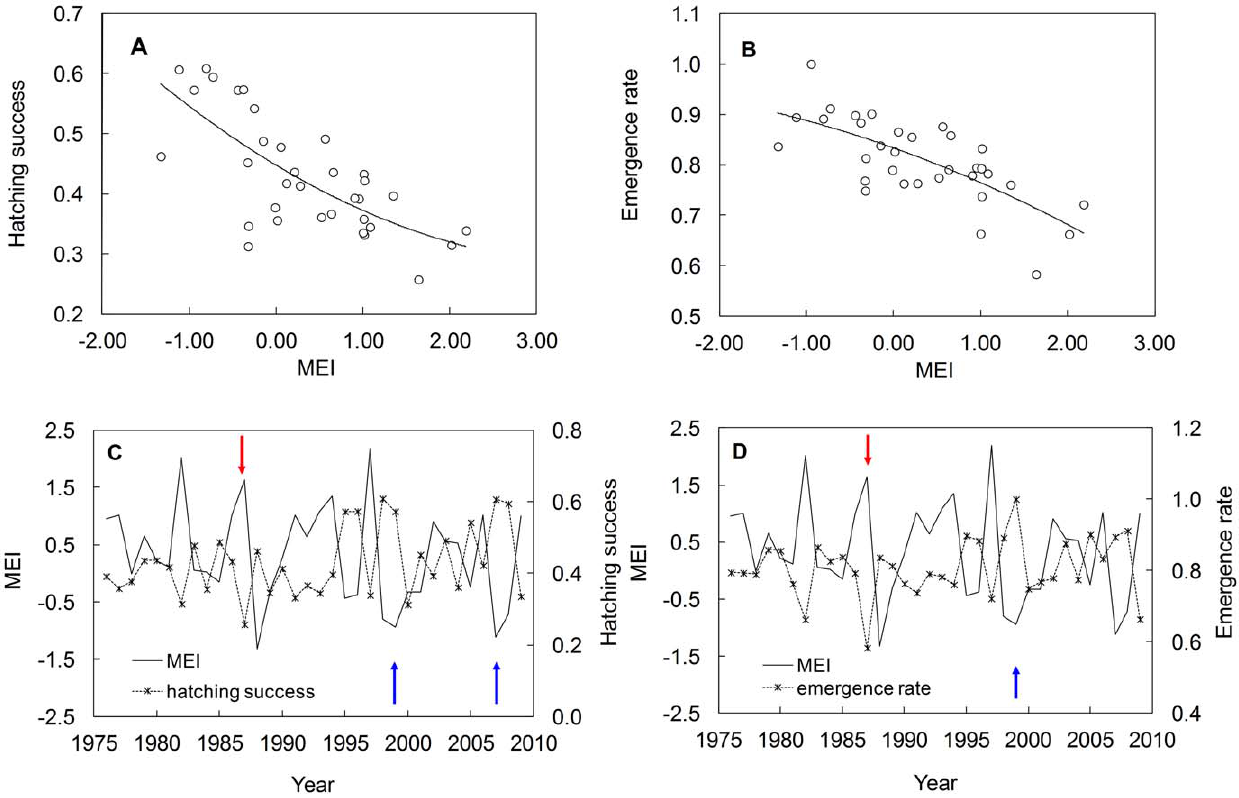
Figure 3. Hatching success and emergence rate hindcasts from 1976–1977 to 2009–2010 related to MEI. (a,b) hindcast of hatching success and emergence rate in relation to MEI of September-October ( R 2 =0.52, P , 0.001 for both); (c,d) hindcast of hatching success and emergence rate (dashed lines with x’s) related to MEI (solid lines) of September-October by year. Lowest and highest hindcasts are marked with red and blue arrows